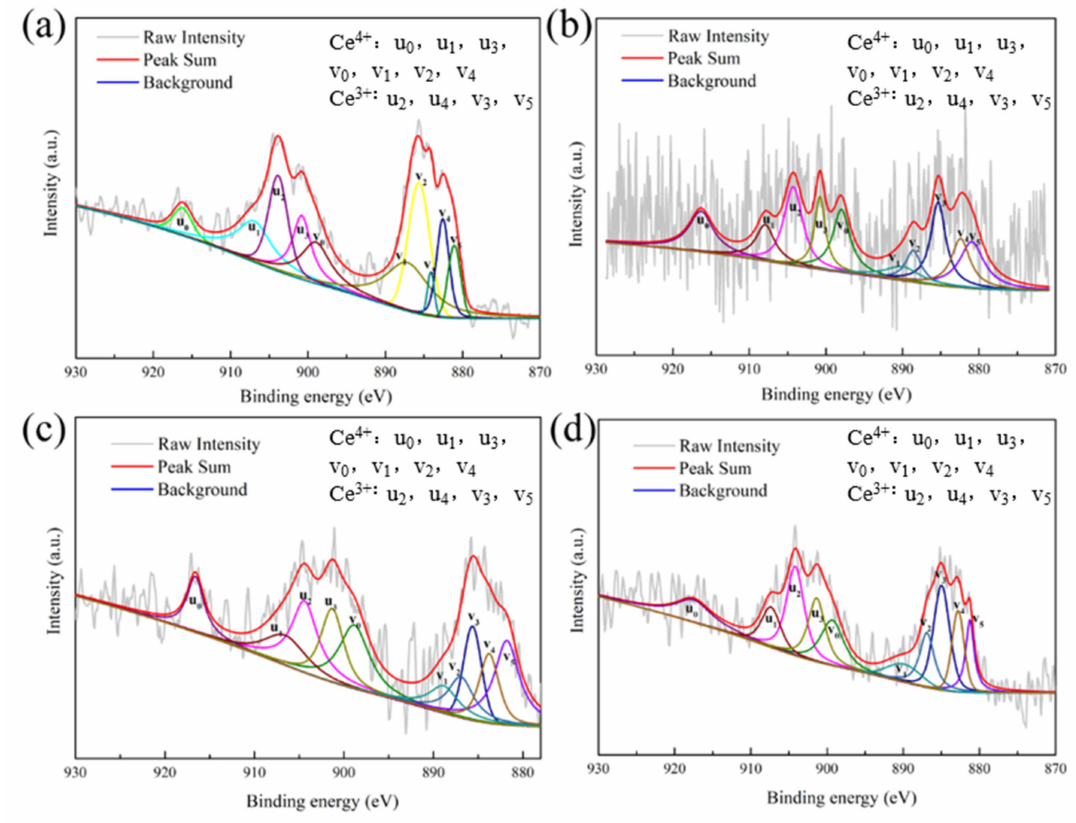
Figure 12. ( a ) Ce-2, ( b ) Ce-4, ( c ) Ce-6, and ( d ) Ce-8 peak fitting curves for the XPS spectra of the Mg 70 − x Zn 30 Ce x (x = 2, 4, 6 and 8) amorphous